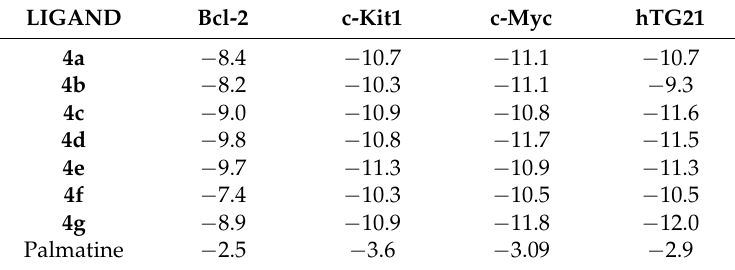
Table 2. Docking results for palmatine and palamtine